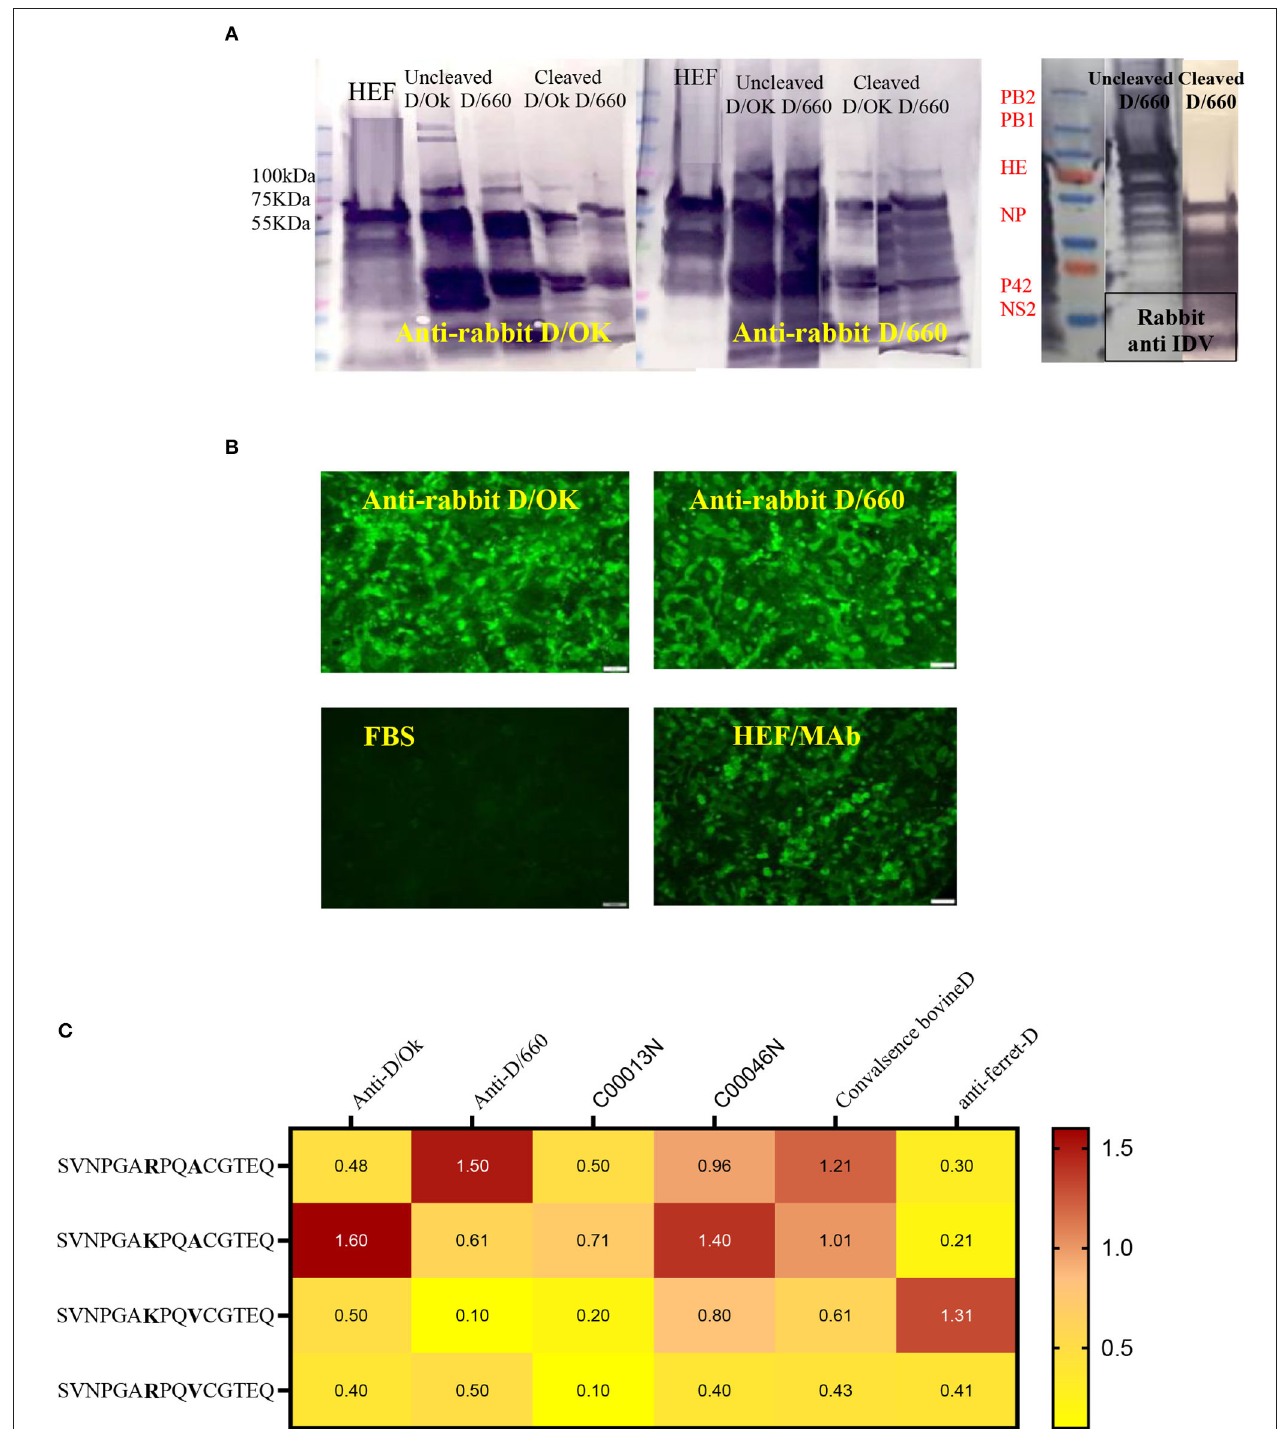
FIGURE 3 | Cross-reactivity between two IDV different clades of D/660 and C/OK. (A) Cross-reactivity between the two IDV different clades of D/660 and C/OK using specific polyclonal rabbit anti-IDV sera against each clade and using polyclonal rabbit anti-IDV/D/660 and polyclonal rabbit anti-IDV/C/OK sera against cleaved and non-cleaved viruses. (B) Cross reactivity of the mutant HE protein at the site 212 amino acid. MDCK cells were stained with both IDV lineages of anti-rabbit-sera and mAb after transfection in MDCK cells. (C) List of peptides used and recognition of both D/OK and D/660 antibodies.